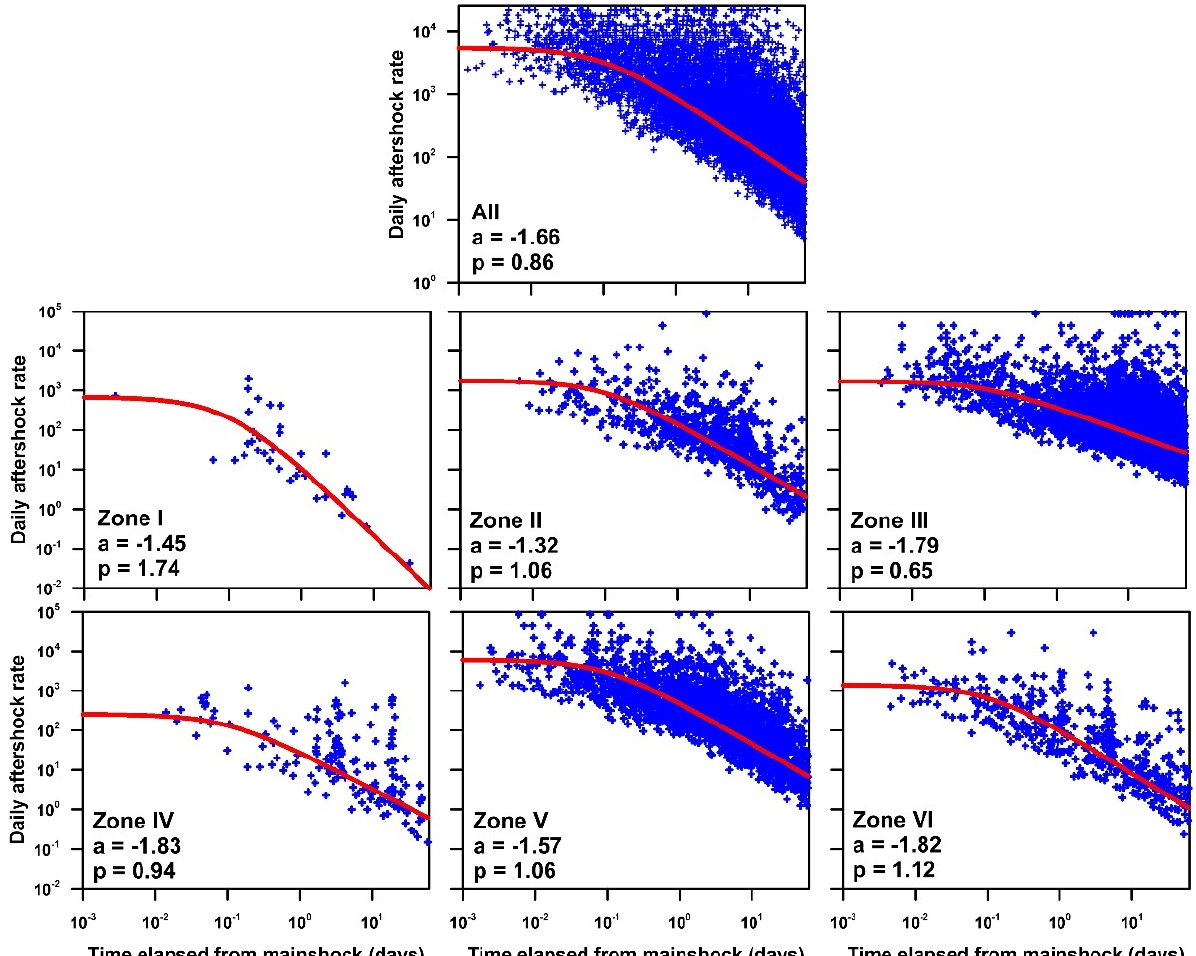
Figure 4. Stacked fits of the RJ89 model for seismic sequences located within each seismic zone of Figure 1. Red lines denote the maximum likelihood fit of the aftershock rates for M ≥ M c .